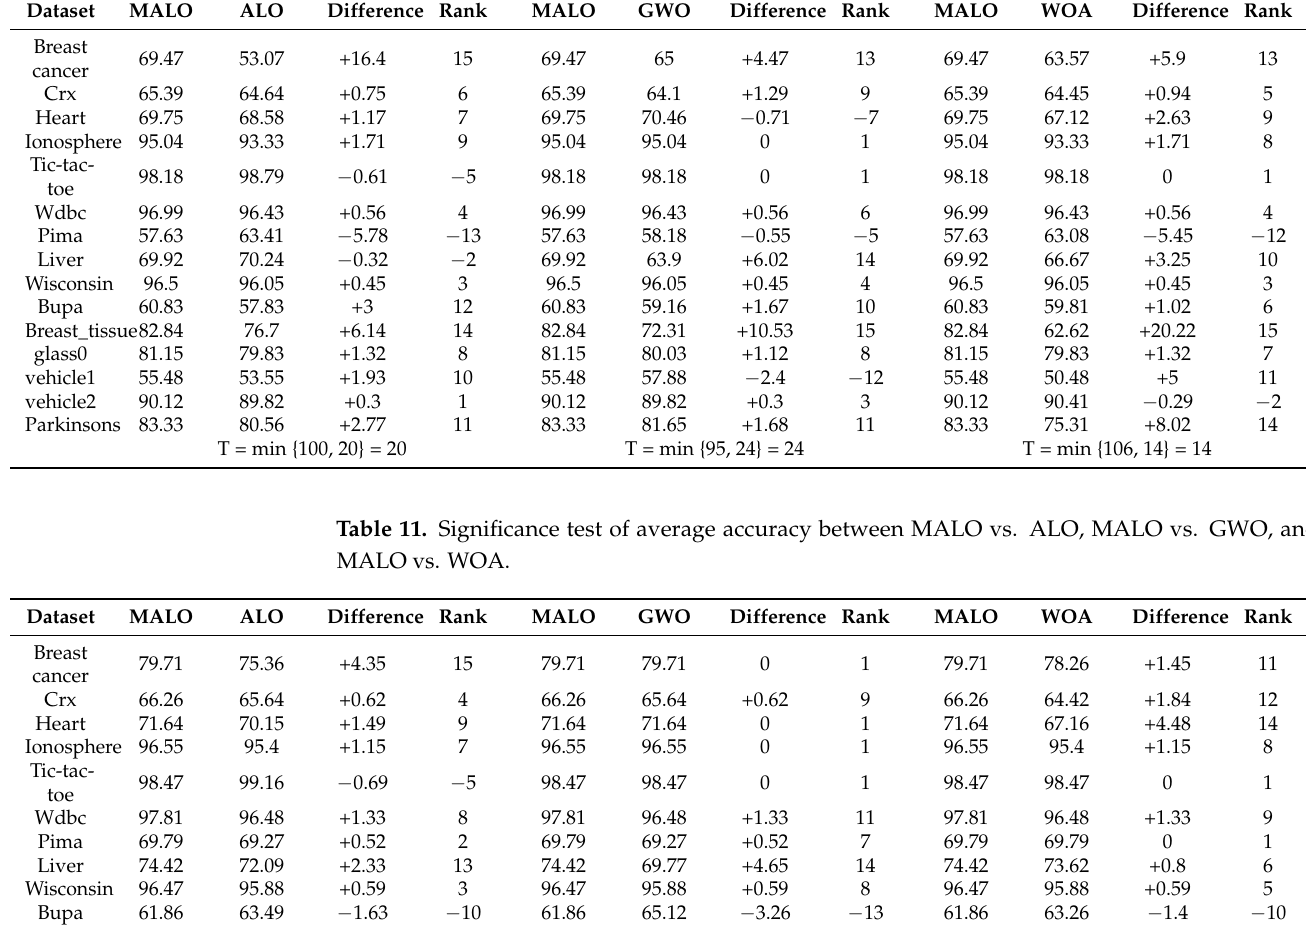
Table 10. Significance test of average g-mean between MALO vs. ALO, MALO vs. GWO, and MALO vs. WOA.